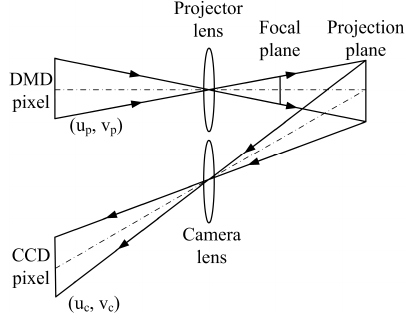
Figure 8. Model of a structured light system with an out-of-focus projector.